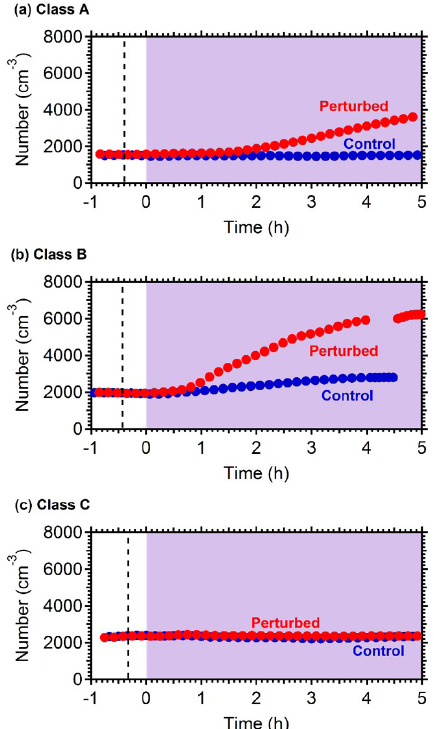
Figure 1. Wall loss corrected number concentration N 9 in the three different types of experiments, (a) NPF and growth only in the per- turbed chamber (Exp. A1), (b) NPF and growth in both chambers (Exp. B1) and (c) no NPF observed (Exp. C1). The dashed line marks the time that ammonia was injected in the perturbed